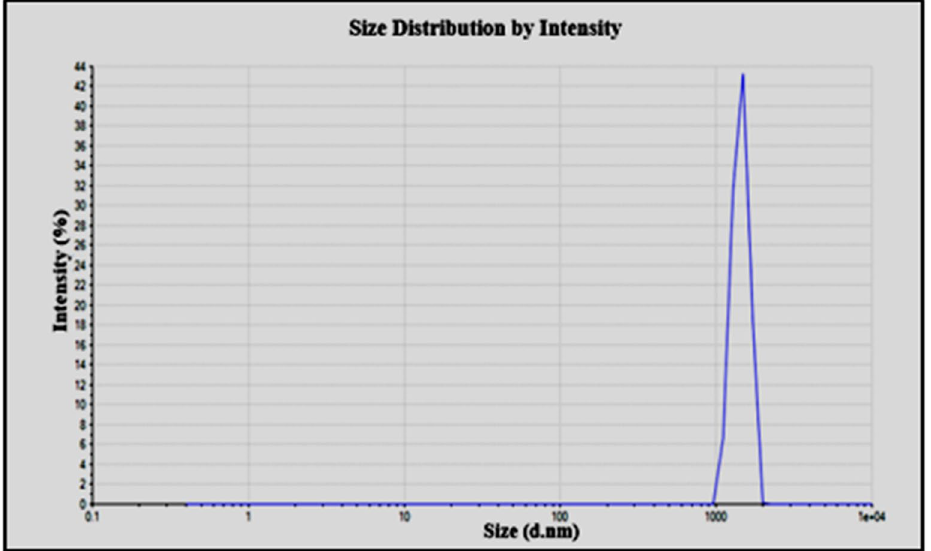
Figure 4. Size distribution by Intensity of FeNPs synthesized from Phoenix dactylifera leaves extract.